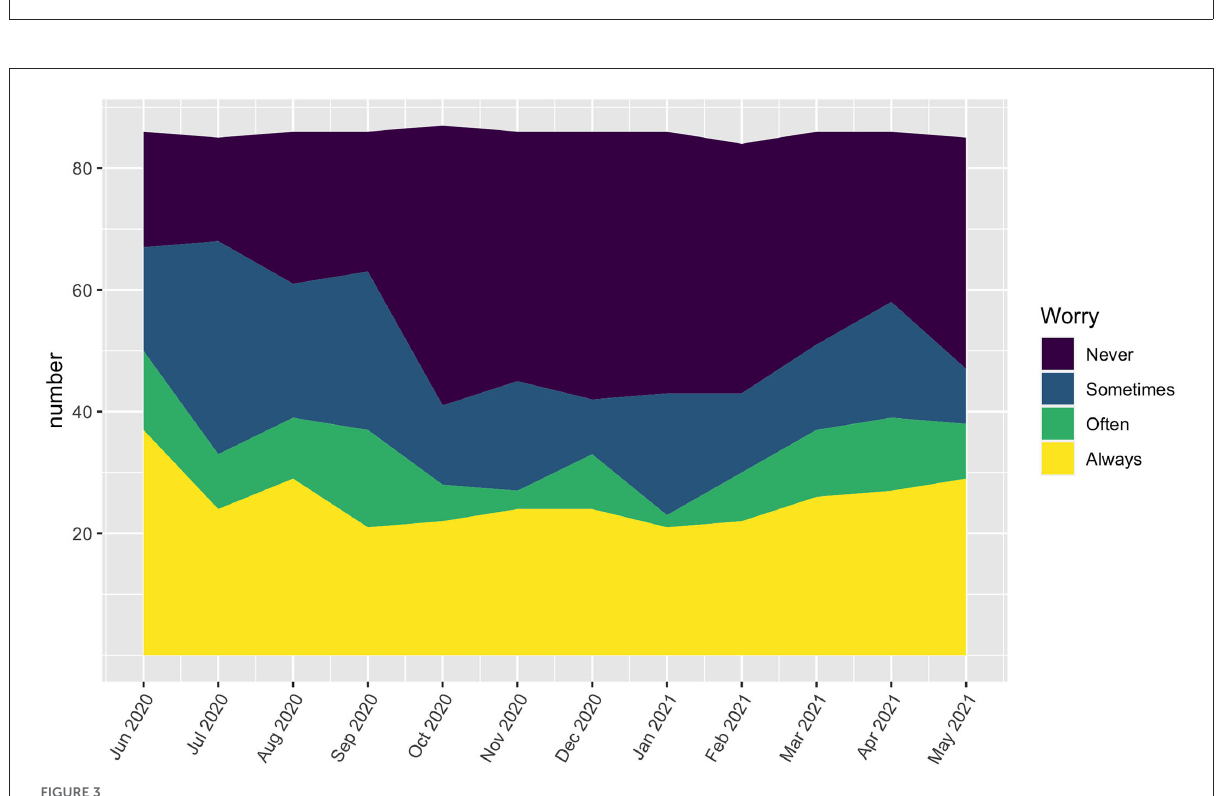
FIGURE3 Worry about effects of COVID-19 measures on